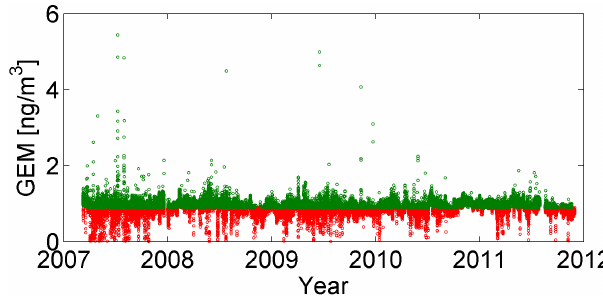
Figure 2. Average silhouette numbers for the various cluster solu- tions. An increase in silhouette numbers indicates that individual sub-clusters are better separated. Table 1. The percentage GEM data distribution observed for each cluster solution.